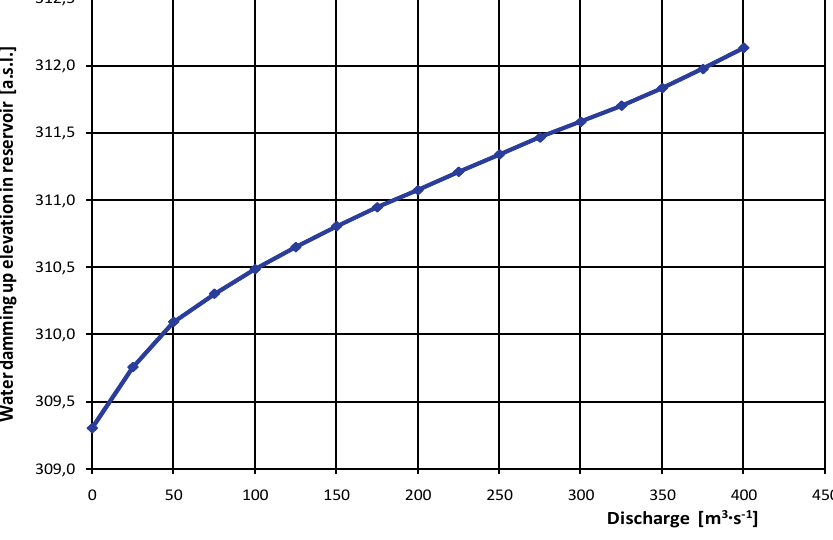
Fig. 7. Hydraulic characteristics of side channel spillway for the proposed